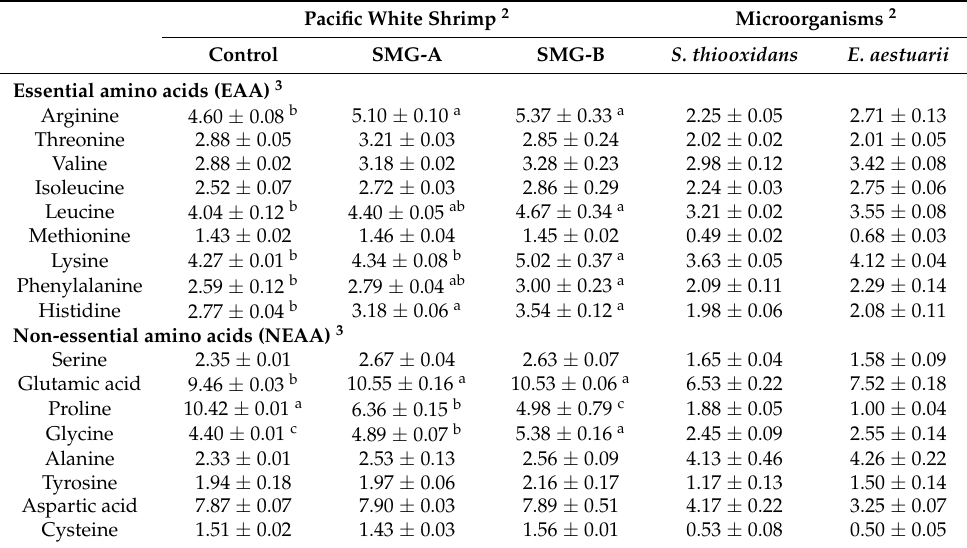
Table 3. Whole-body amino acid compositions (mg 100 mg − 1 ) of the Pacific white shrimp cultured in the control, SMG-A, and SMG-B groups after 6 weeks of culture 1 .